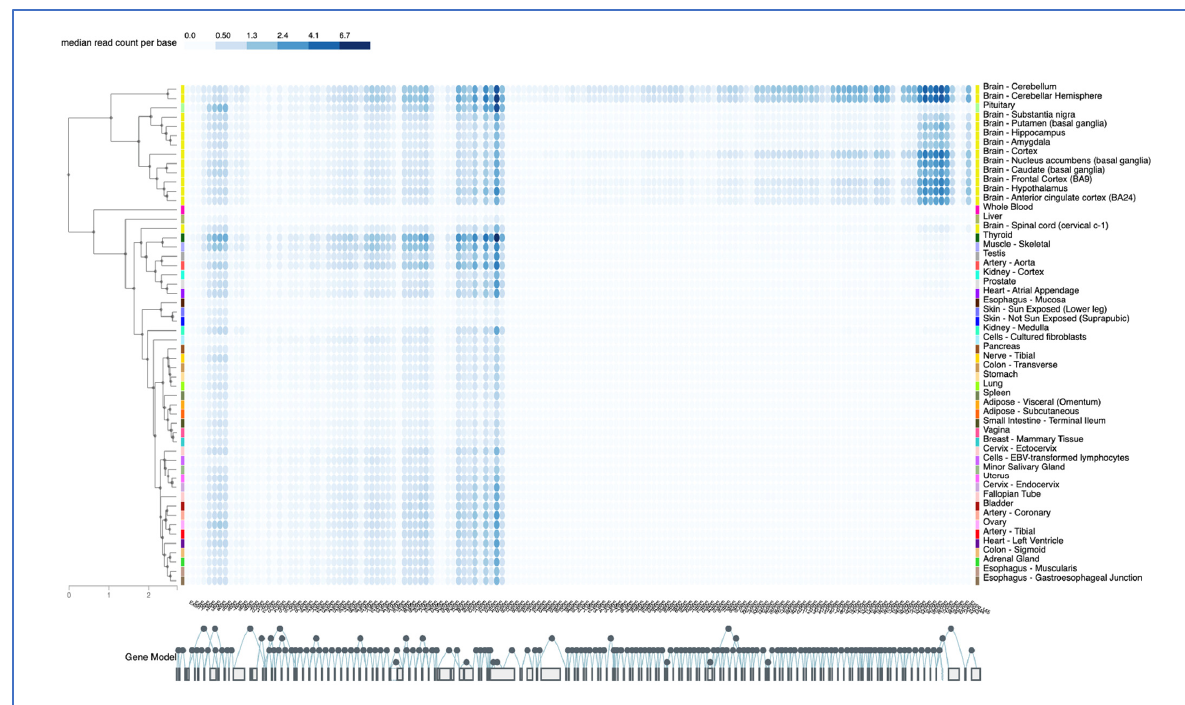
Figure 5. GTEX Exon expression pattern. The GTEX portal was used in the exon expression mode to examine exon-specific transcripts in tissues, color-coded as in Figure 4, and listed in alphabetically order. The 145 exons of the SNHG14 gene are shown below, with alternative and sequential splicing noted by the filled circles. Alternative splicing is shown as circles above and below the main circles, which are sequential. The Genotype-Tissue Expression (GTEx) Project [28] was supported by the Common Fund of the Office of the Director of the National Institutes of Health and by NCI, NHGRI, NHLBI, NIDA, NIMH, and NINDS. The data used for the analyses described in this manuscript were obtained from the GTEx Portal on 12/28/22. The color code corresponds to read counts per base per exon.